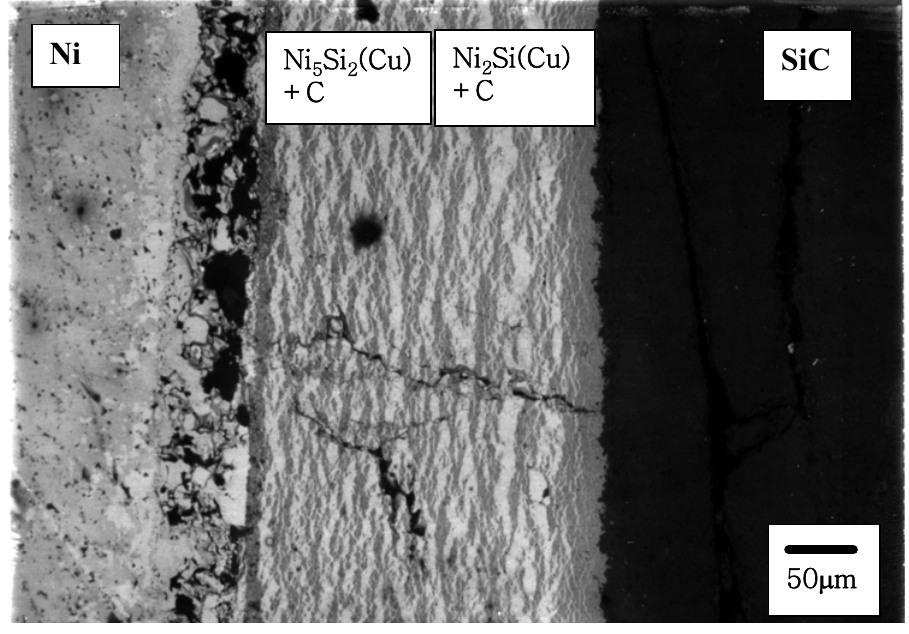
Figure 8. BSE image of Ni/Cu/SiC reaction couple annealed at 900 ° C for 40 h